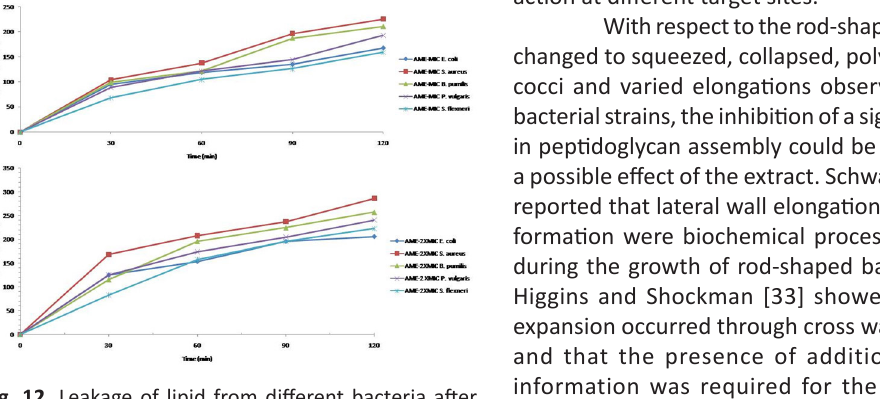
Fig. 12. Leakage of lipid from different bacteria after treatment at their MIC and 2 x MIC.